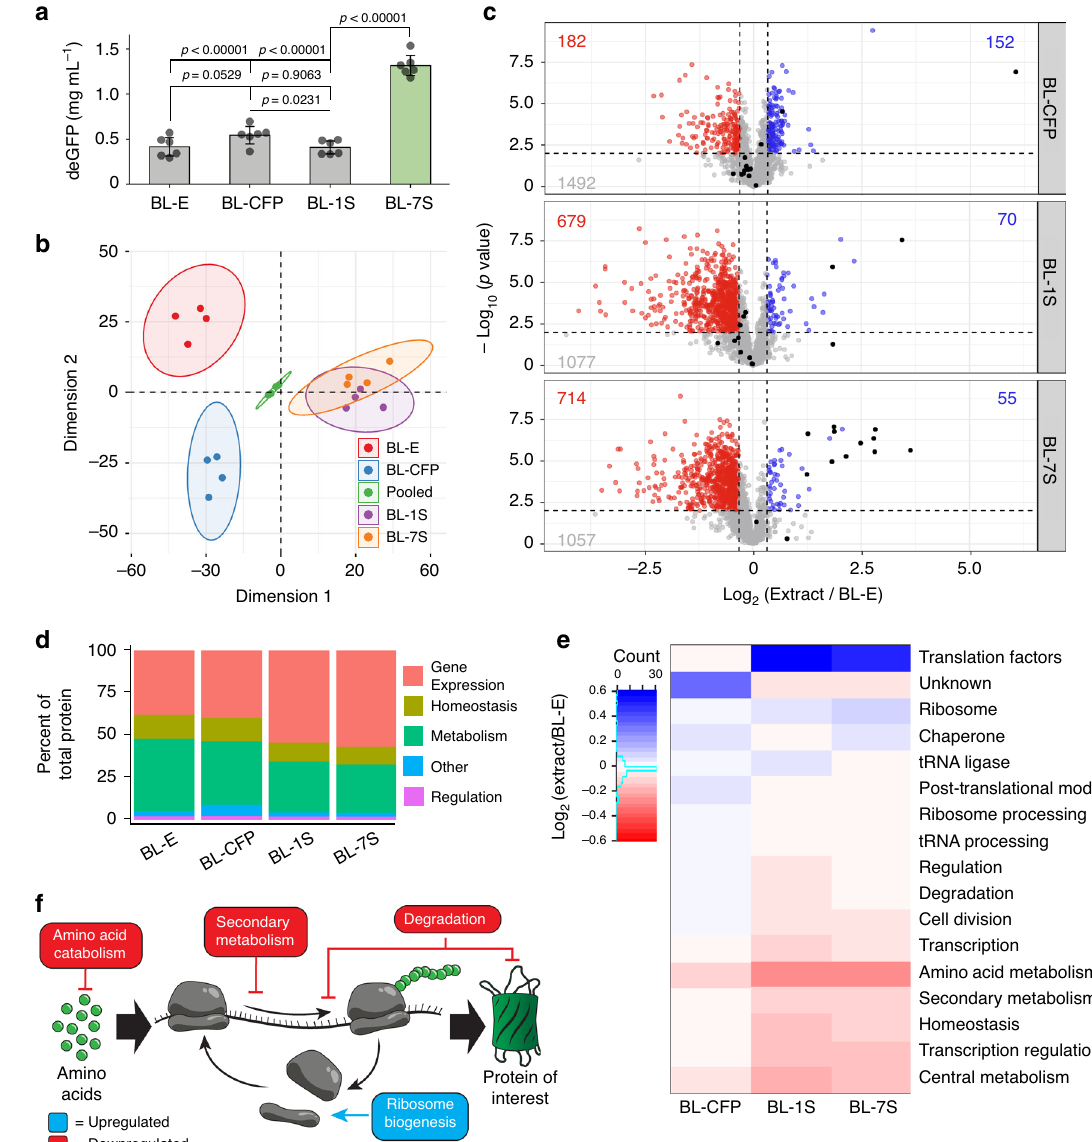
Fig. 3 Mass spectrometry reveals proteome reprogramming. a Expression data of all extracts used in mass spectrometry analysis. Data are presented as mean values and error bars represent s.d. ( n = 6 three independent reactions of two independent extract preparations). Standard two-tail t -test. b Principal component analysis showing the grouping of the various extracts based on their protein pro fi le. Ellipses indicate the boundary for statistical signi fi cance by a two-tailed t -test ( p value< 0.01). Clear grouping is observed between the replicates of each sample. c Volcano plots displaying the changes in protein intensity between each extract and the BL21(DE3) control. Red data points indicate a decrease in protein intensity greater than 25% and a p value< 0.01 from a two-sided t -test. Blue data points indicate an increase in protein intensity greater than 25% and a p value< 0.01 form a two-tailed t -test. The proteins that were intentionally overexpressed are colored black. Numerous statistically signi fi cant changes are observed, many of which are downregulated. d The sum of protein intensity in each category for each extract is presented as percentages of the total protein intensity in that extract. There is a marked increase in gene expression and a decrease in metabolism and homeostasis related proteins when comparing BL-1S and BL-7S to BL-E. e The identi fi ed proteins were further subdivided into more speci fi c functional groups. The log difference between the protein intensity of each extract and BL-E were calculated and then averaged within each functional group and plotted on a colorimetric scale. The dendrogram represents the clustering of each protein group based on their similarity to other groups. CFP was inserted into the Unknown category. f Diagram of translation indicating the key changes in the proteome and their in fl uence on gene expression. Source data for a – e are provided as a Source Data fi le. In b – e use the same samples throughout. ( n = 4 two independent samples from two independent extract